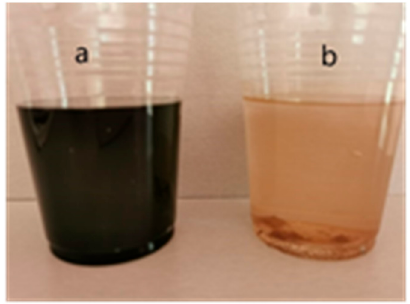
Figure 1. ( a ) Tattoo ink diluted in water, ( b ) PMU color diluted in water. Image courtesy of Eleni- Andreou.